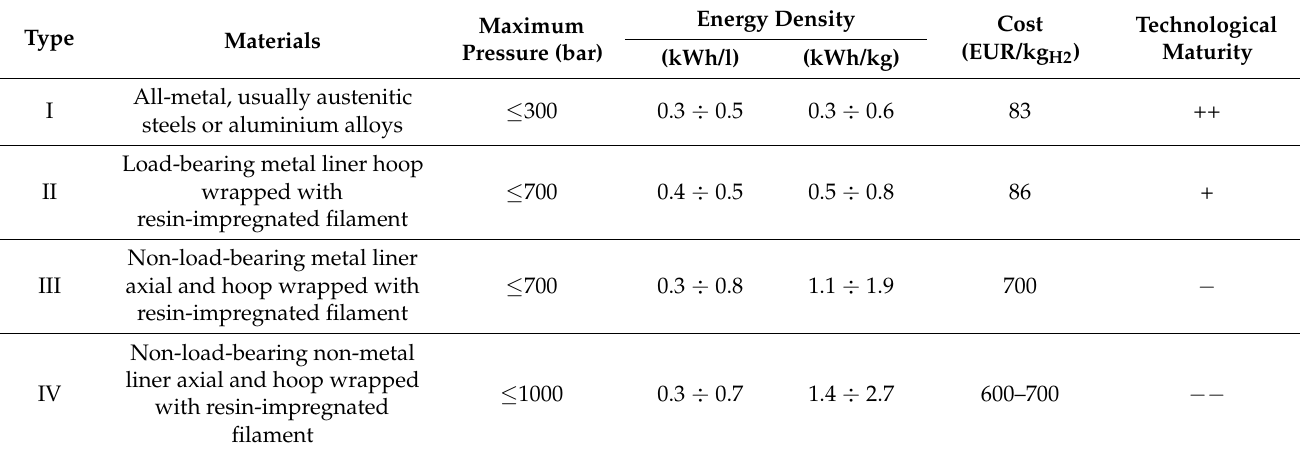
Table 1. Main characteristics of CH 2 cylinders [28,30–38]. Values of gravimetric and